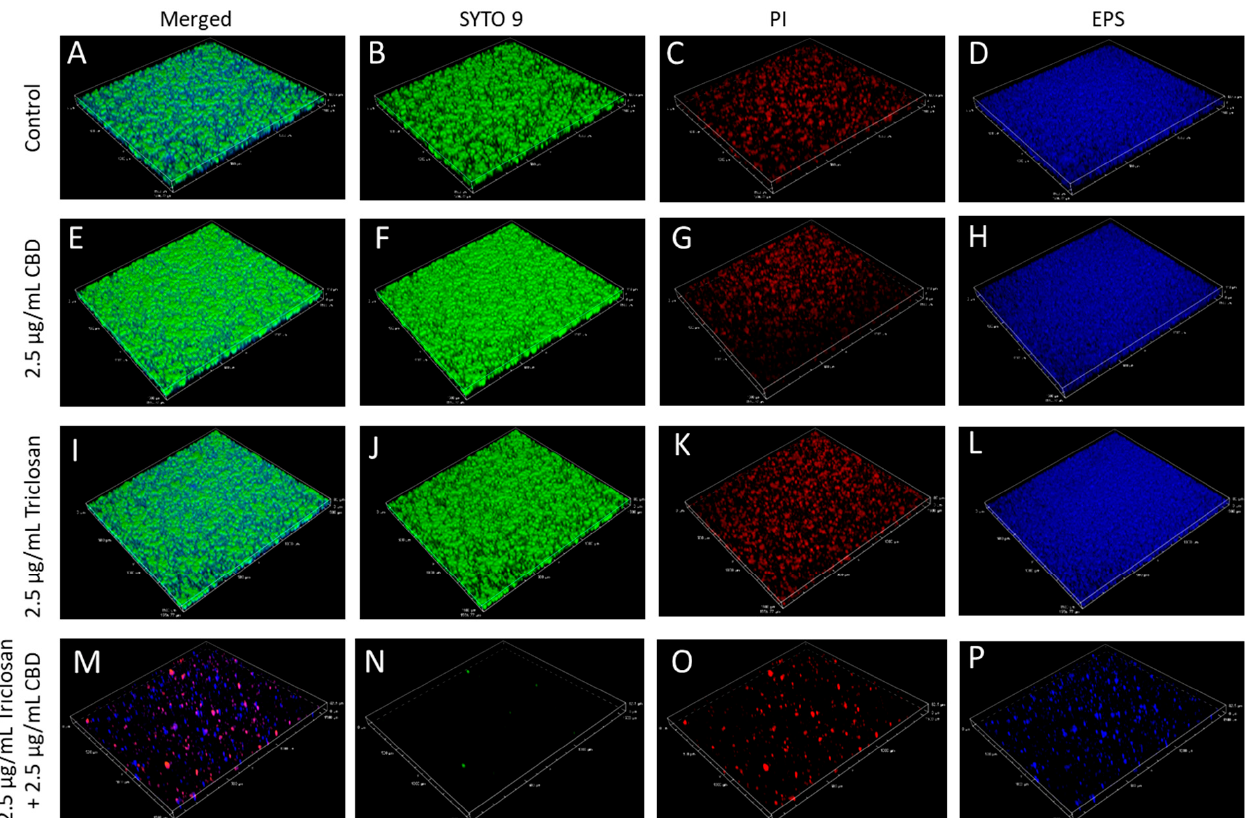
Figure 9. Spinning disk confocal microscope (SDCM) 3D images of S. mutans biofilms that were formed after a 24 h incubation with the indicated concentrations of triclosan and CBD. ( A – P ) The biofilms were stained with SYTO 9 (green fluorescence) ( B , F , J , N ), PI (red fluorescence) ( C , G , K , O ) and AlexaFluor 647 -conjugated Dextran 10,000 (presented in a blue color) ( D , H , L , P ), which stains EPS. The merged images are shown in ( A , E , I , M ). The combined treatment of triclosan with CBD results in the prevention of biofilm formation with only few dead bacteria attached to the surface.